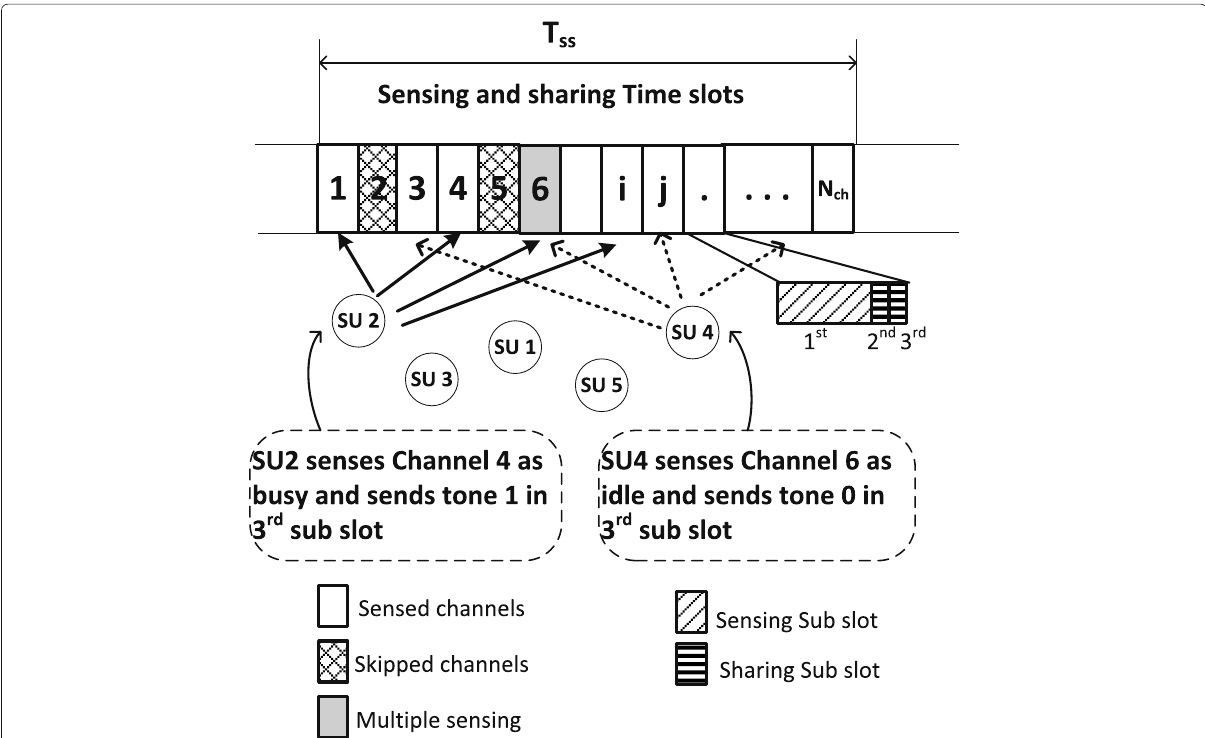
Fig. 1 Secondary users randomly select the time slots in sensing and sharing phase for sensing idle or busy channels in the primary user